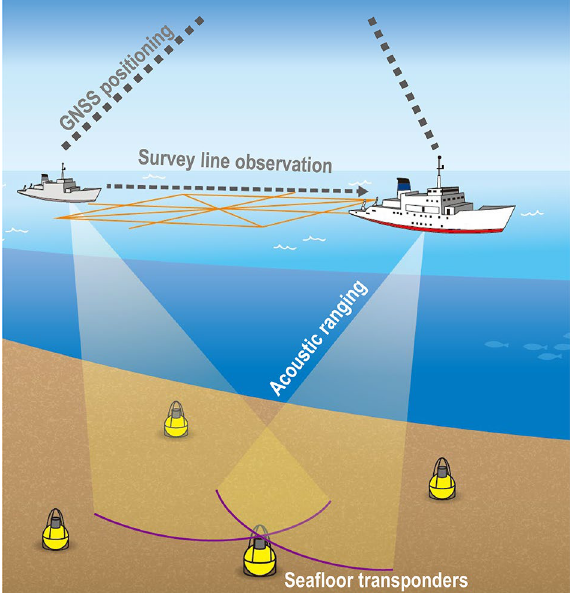
Figure 1. Schematic illustration of GNSS-A observation system. The GNSS observations and the acoustic ranging to the seafloor transponders are performed on the sea surface platform (vessel in this figure) moving along the survey line. This figure was modified after Refs 14, 41 .